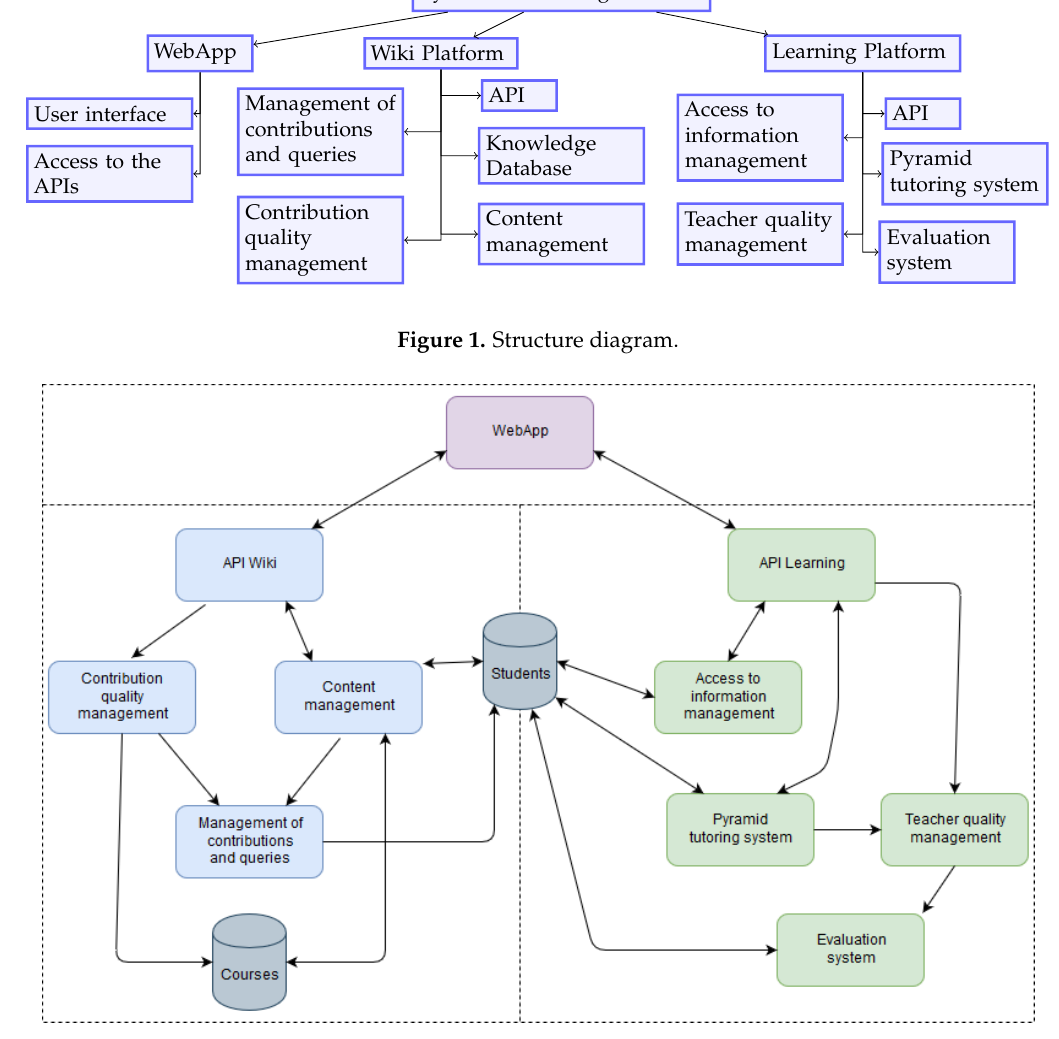
Figure 2. Organizational